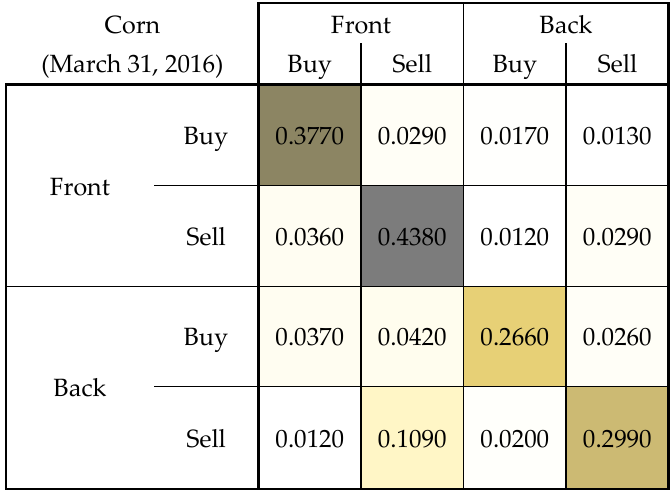
Figure 5. Composition of the estimated intensity for corn and live cattle. Compared to the relative contribution of 𝜇 (cid:3036) , the relative contribution of the kernel norms ‖𝜙 (cid:3036)(cid:3036) ‖ (cid:2869) to the total intensity is considerably larger. More specifically, the relative contribution of ‖𝜙 (cid:3036)(cid:3036) ‖ (cid:2869) to the total intensity is largest for the back contract of corn. It amounts to roughly 70%, which means that market reflexivity accounts for about 70% of the total intensity of both buyer-initiated and seller- initiated transactions for the back contract of corn. Moreover, the relative contribution of ‖𝜙 (cid:3036)(cid:3036) ‖ (cid:2869) is clearly larger in the back contract than in the front contract for corn. In contrast, the relative contribution of ‖𝜙 (cid:3036)(cid:3036) ‖ (cid:2869) is of similar size in the front and back contract for live cattle.